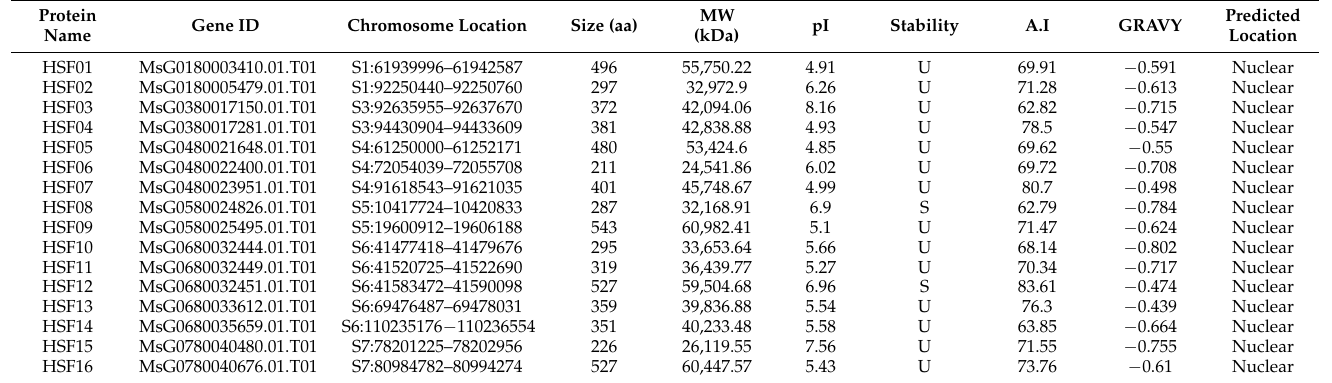
Table 1. Prediction of physicochemical properties of